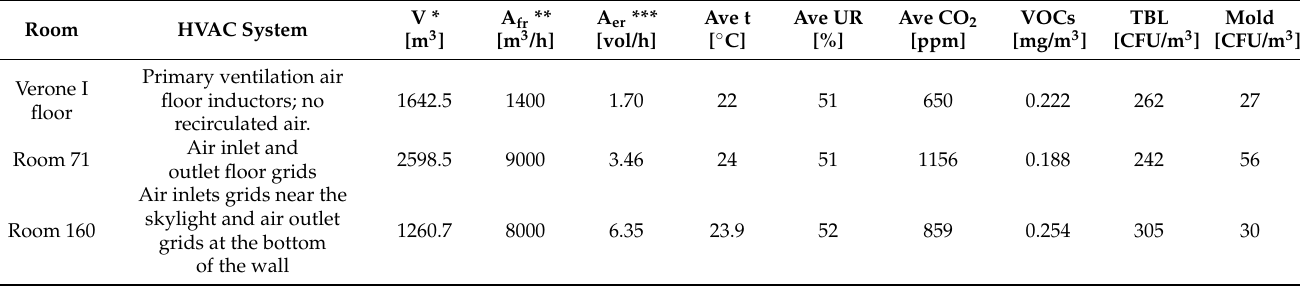
Table 9. Comparison among the main values detected during the indoor monitoring campaign and the main characteristics of the HVAC systems present in the analyzed